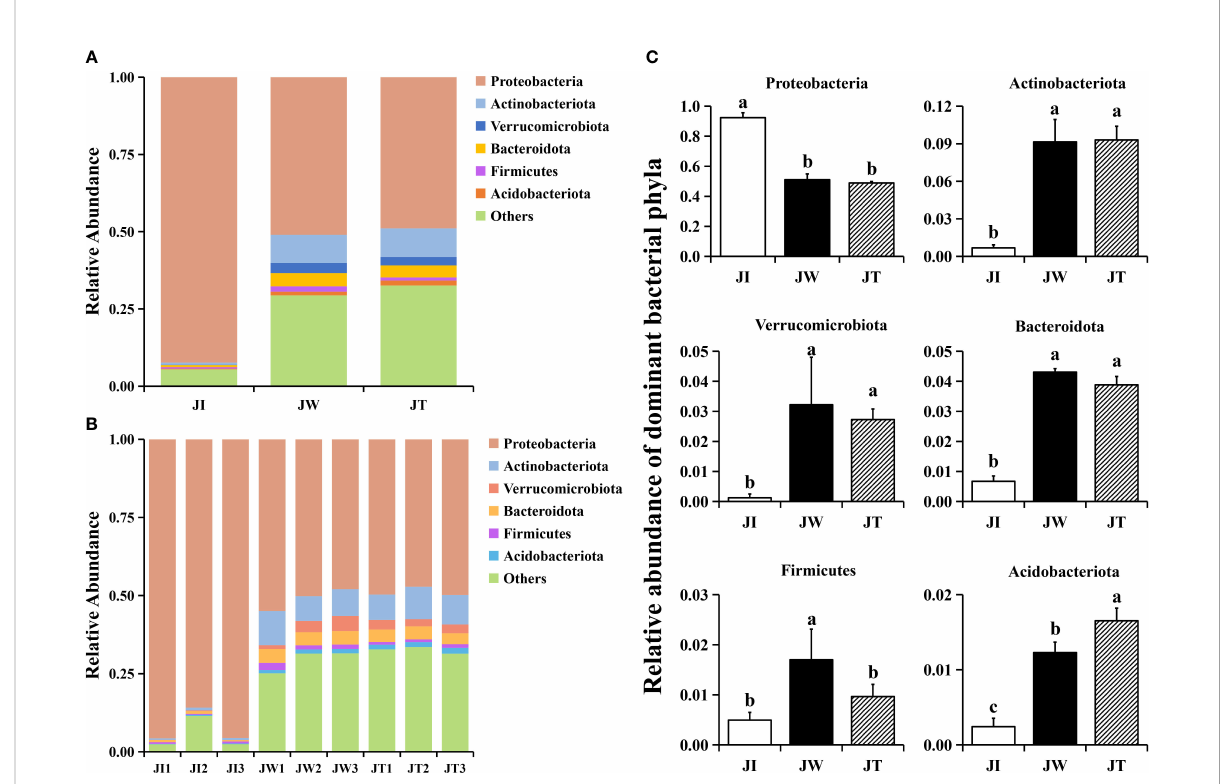
FIGURE 3 Structure and composition of the intestinal bacterial communities among shrimp intestines (JI), water (JW), and ef fl uent (JT) samples in “ Fishery- PV Integration ” ponds at the phylum level of taxonomy. (A) Relative abundance of phyla across the three groups, (B) the phyla appearing in each sample, and (C) changes in the abundance of dominant bacterial phyla. Data are presented as mean ± S.D. Dissimilar letters show signi fi cant difference ( P <